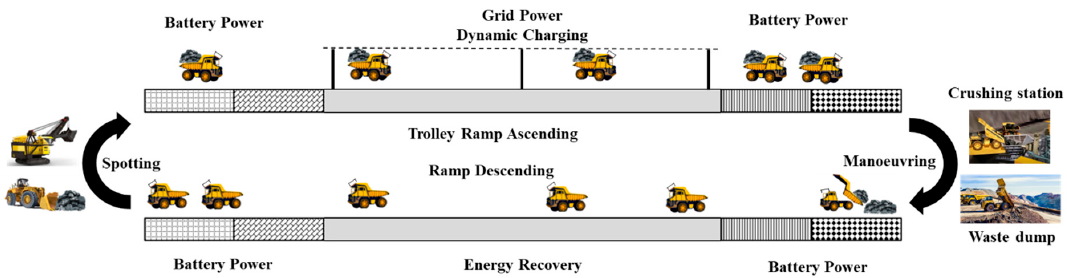
Figure 14. A schematic of dynamic charging BT systems power source.